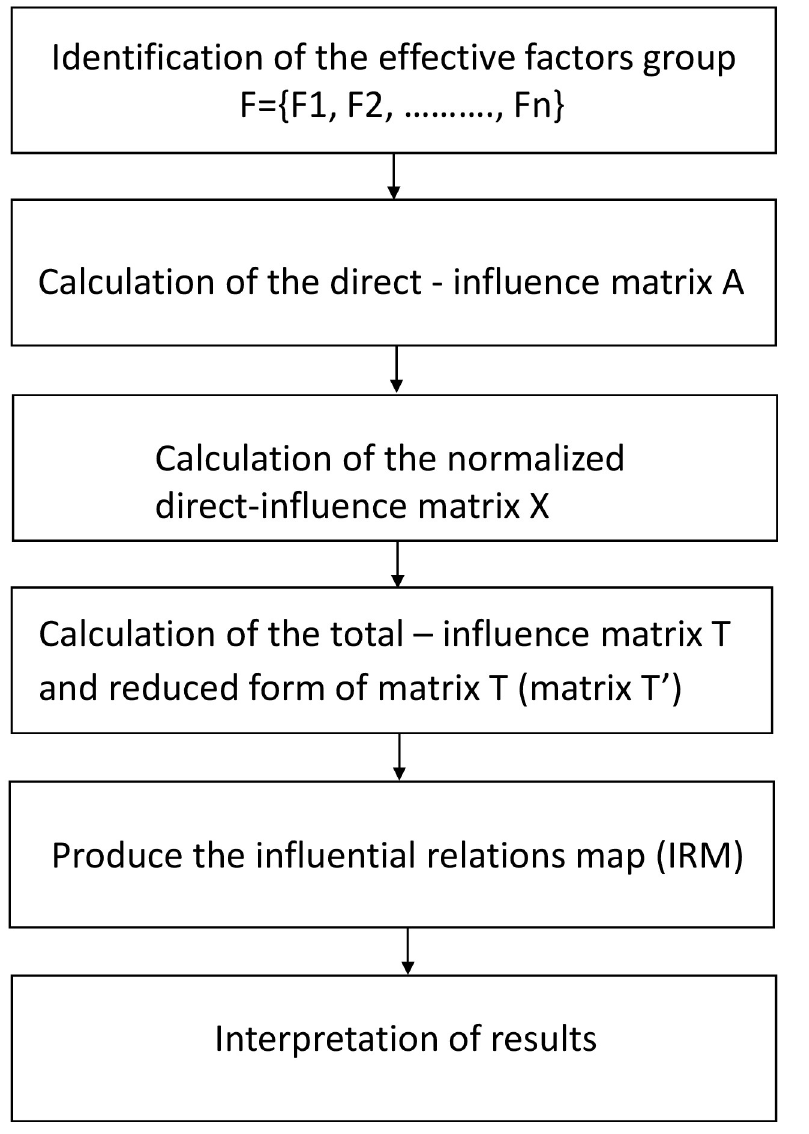
Fig 1. Flow chart for calculation steps in the DEMATEL